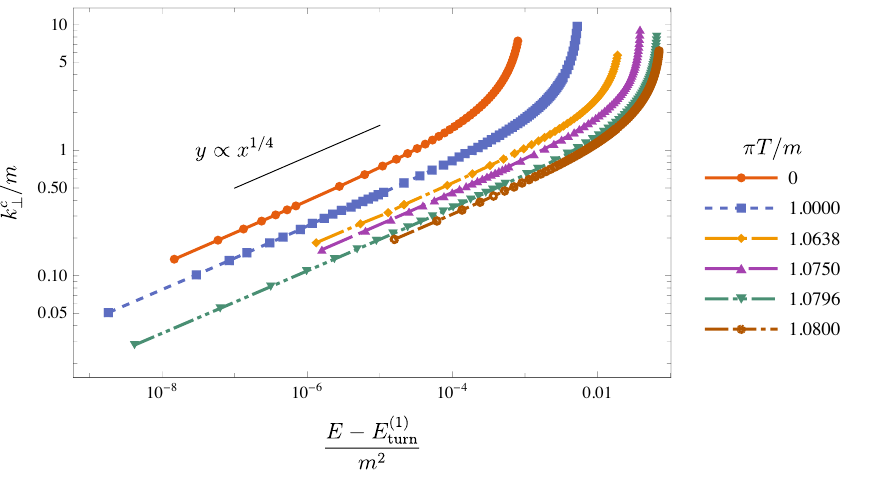
Figure 15 . The relation between the value of J at k c circles). That corresponds to endpoints of each curve at k c denotes the first turning point on each E – J curve, which is identical to that shown in the left panel of figure 3. The plot shows that the turning points, at which the zero-modes with ω = k ⊥ = 0 appear, have a non-monotonic dependence on the temperature.